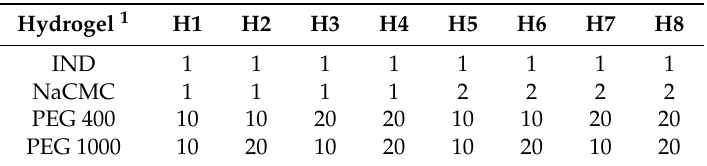
Table 7. Composition of the designed